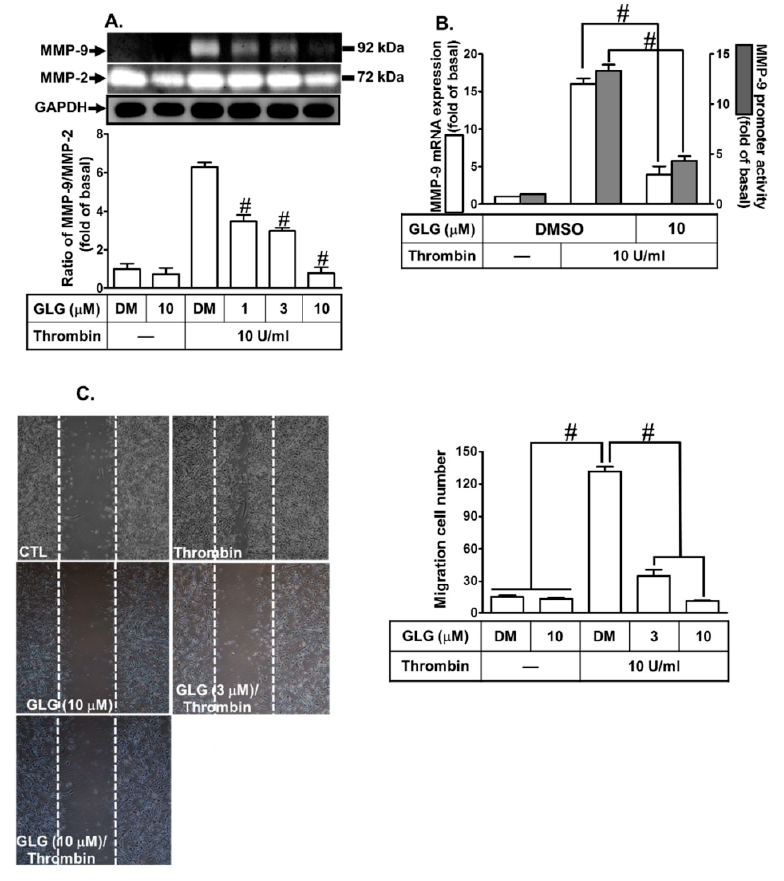
Figure 1. Galangin (GLG) reduces thrombin-induced pro-form (pro) MMP-9 expression and cell migration in SK-N-SH cells. ( A ) The cells were pretreated with galangin (1, 3, 10 µ M) for 1 h and then incubated with 10 U/mL thrombin for 16 h. The conditioned cell culture media were collected to measure the MMP-9 expression by gelatin zymography. The activity of proMMP-9 was normalized to that of MMP-2. The cell lysates were analyzed by western blot to determine the expression of glyceraldehyde-3-phosphate dehydrogenase (GAPDH), serving as the marker for the cell